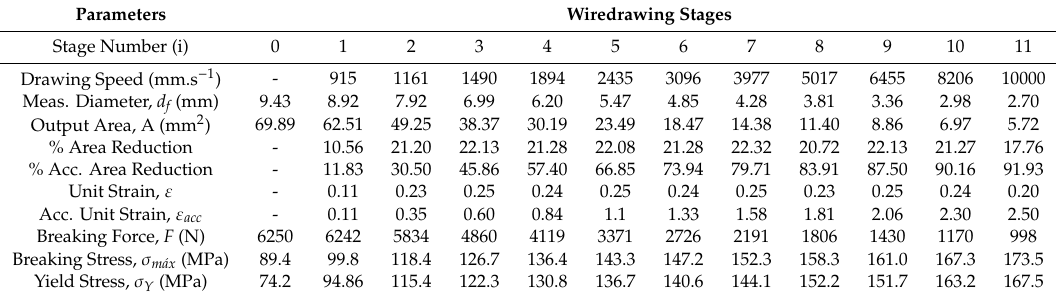
Figure 4. Force vs. elongation graph obtained in the tensile tests (samples of each of the stages). Table 4. Process data and limit stresses obtained from the tensile tests.